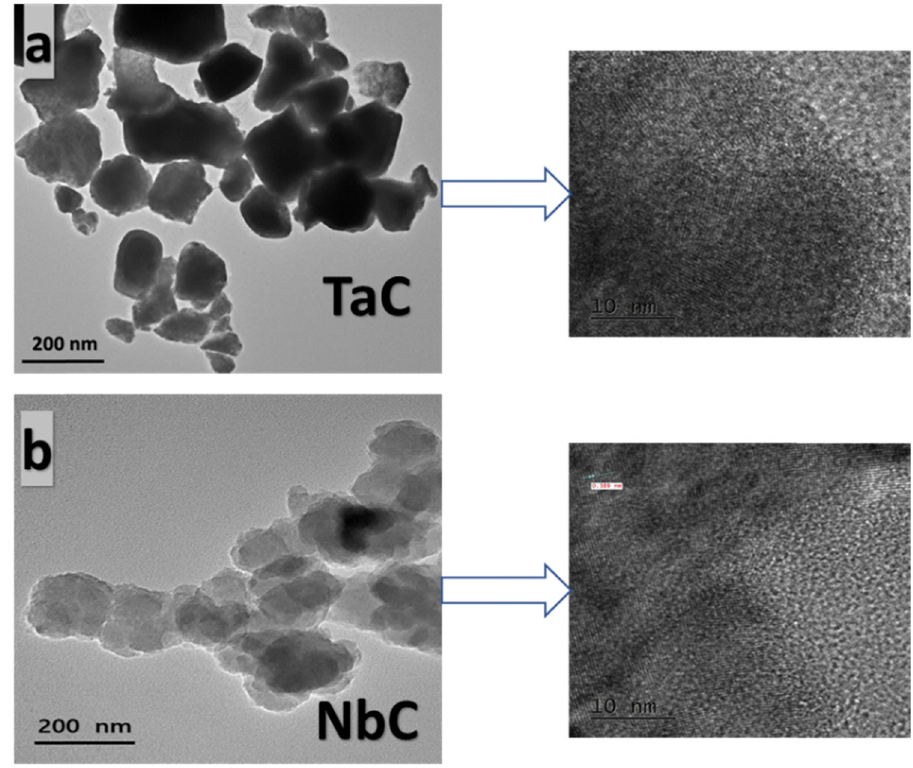
Figure 2: TEM images of ( a ) TaC and ( b ) NbC nanoparticles and corresponding crystal structures.